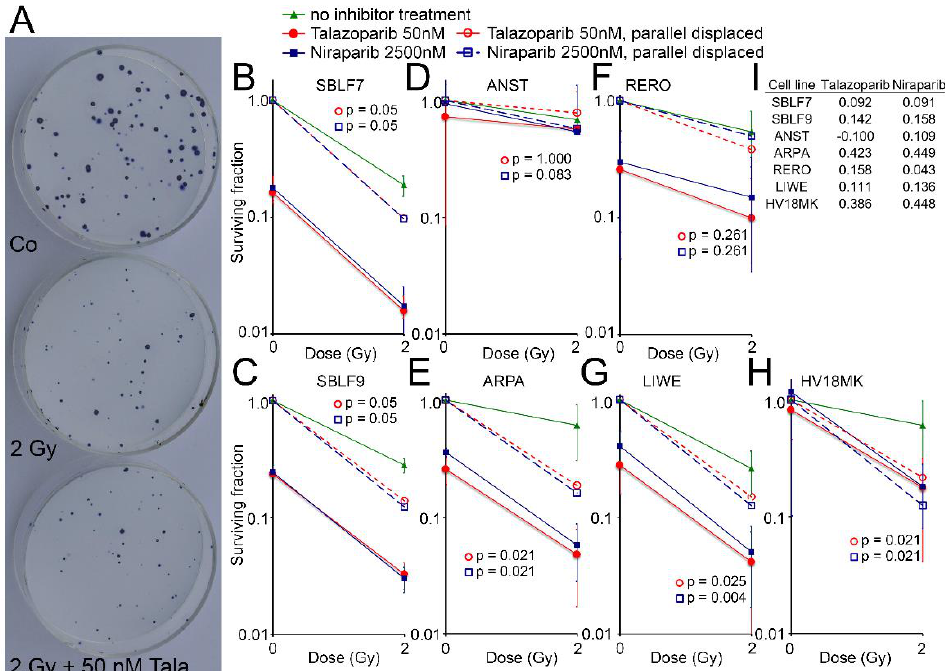
Figure 4. Colony formation assay after combined PARPi plus IR treatment. ( A ) Representativ colony formation assay in petri dishes of skin cancer cell line RERO untreated (Co), irradiated (2 Gy) and after combined therapy (2 Gy + 50 nM Talazoparib). ( B – H ) Surviving fraction after 0 and 2 Gy IR and after treatment with the PARPi Talazoparib (50 nM, red lines) respectively Niraparib (2500 nM, blue lines) (Solid lines). Normalized values for the effect of the inhibitors (stripped lines). ( I ) The difference between the parallel displaced values of the combined effect and the radiation effect alone indicating the increased effect of the combined treatment.